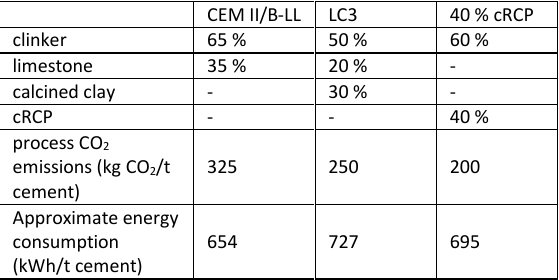
Table 2. Assumed cement compositions and resulting process CO 2 emissions and approximate energy